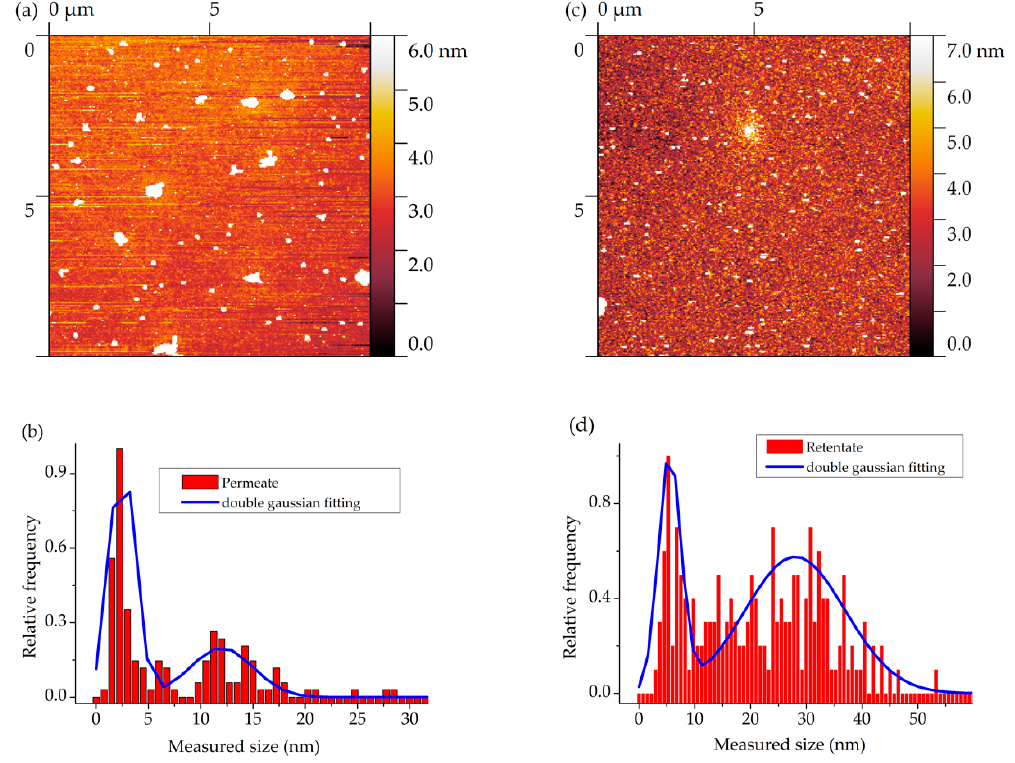
Figure 3. ( a ) AFM picture and ( b ) size distribution of the permeate, and ( c ) AFM picture and ( d ) size Figure 3. (a) AFM picture and (b) size distribution of the permeate, and (c) AFM picture and (d) size distribution of the distribution of the retentate.